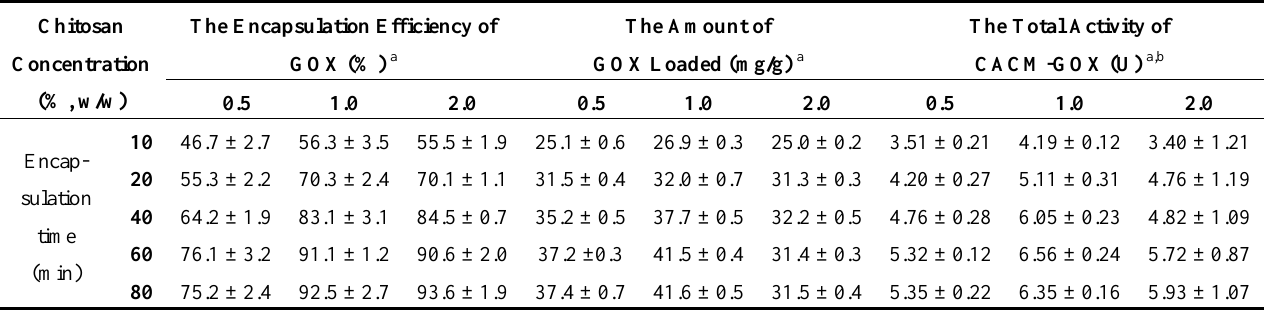
Table 1. Effects of chitosan (MMWb) concentration and encapsulation time on the encapsulation efficiency of GOX, the amount of GOX loaded and the total activity of the immobilized